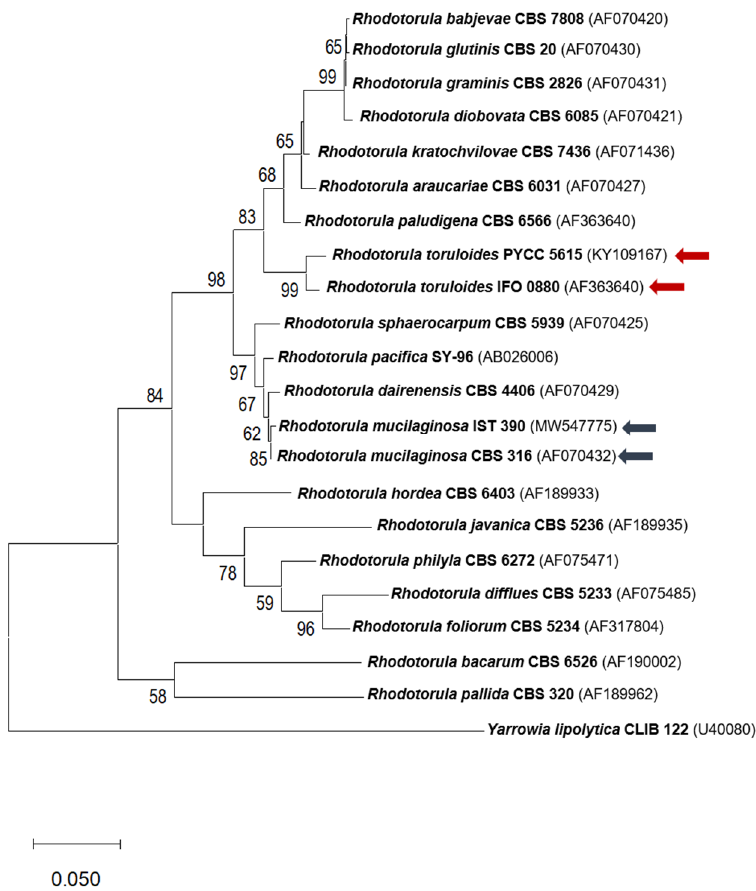
Figure 1. Phylogenetic placement of Rhodotorula mucilaginosa IST 390 based on an alignment of sequences of D1/D2 domains of the 26S rDNA region from other Rhodotorula species, inferred by using the Maximum Likelihood method and Tamura–Nei model. The scale bar indicates the number of expected substitutions per site. The numbers provided on branches are frequencies with which a given branch appeared in 1000 bootstrap replications. The red and blue arrows indicate R. toruloides and R. mucilaginosa branches, respectively. The tree was rooted with Yarrowia lipolytica CLIB 122 (Collection de Levures d'Intérêt Biotechnologique).